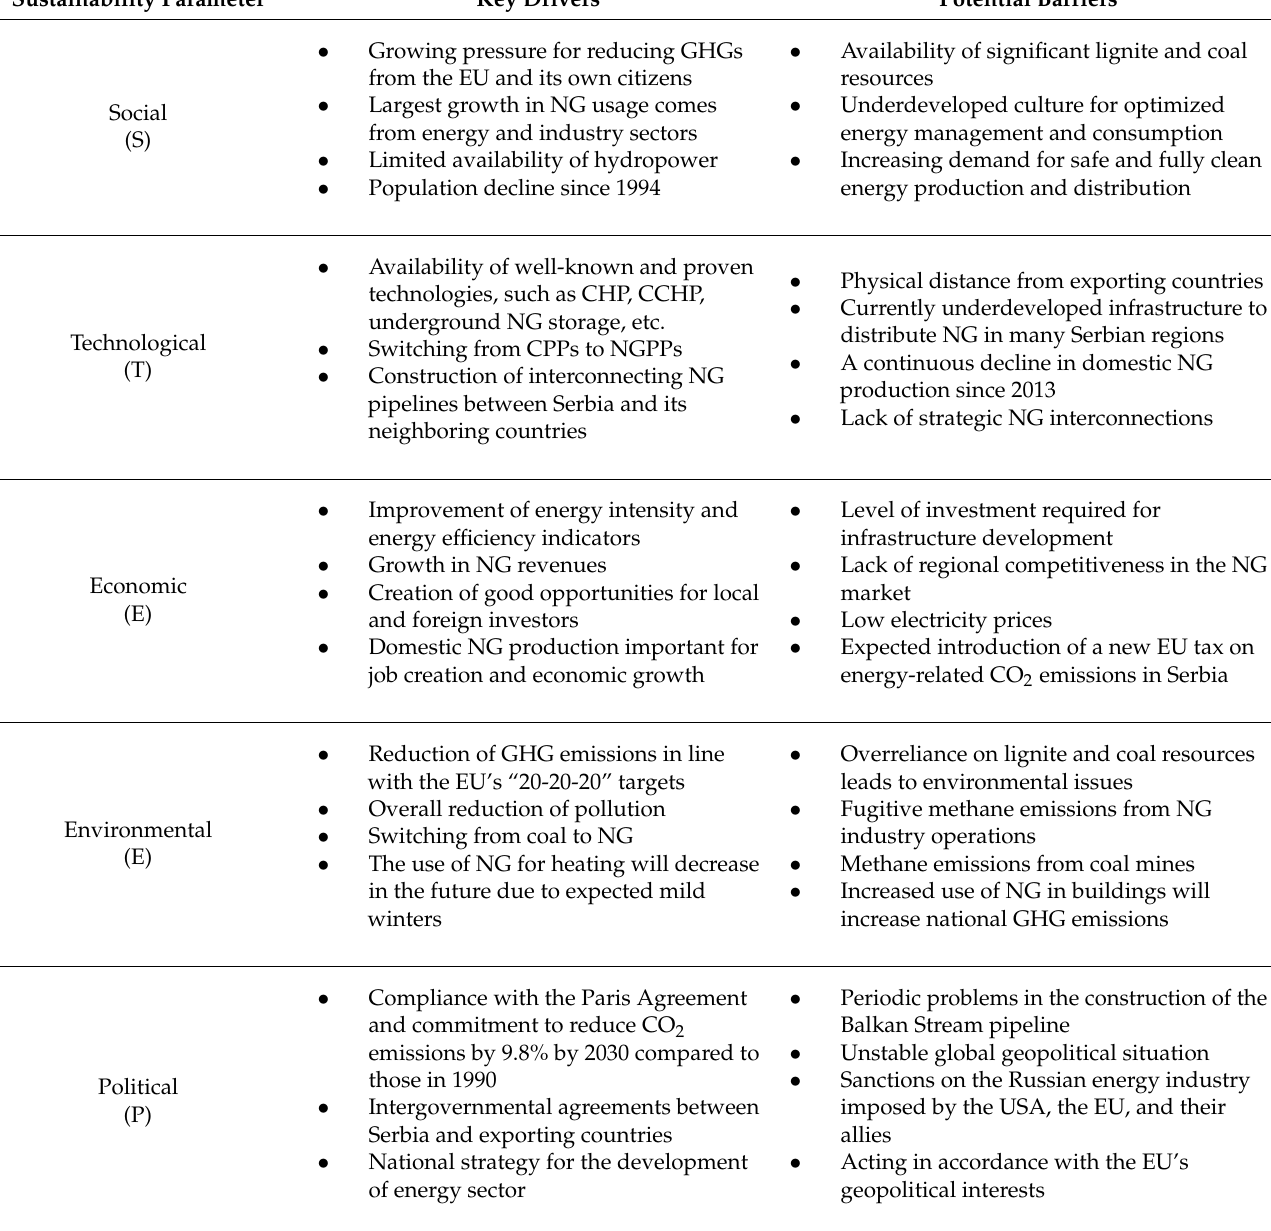
Table 4. STEEP parameters in the case of